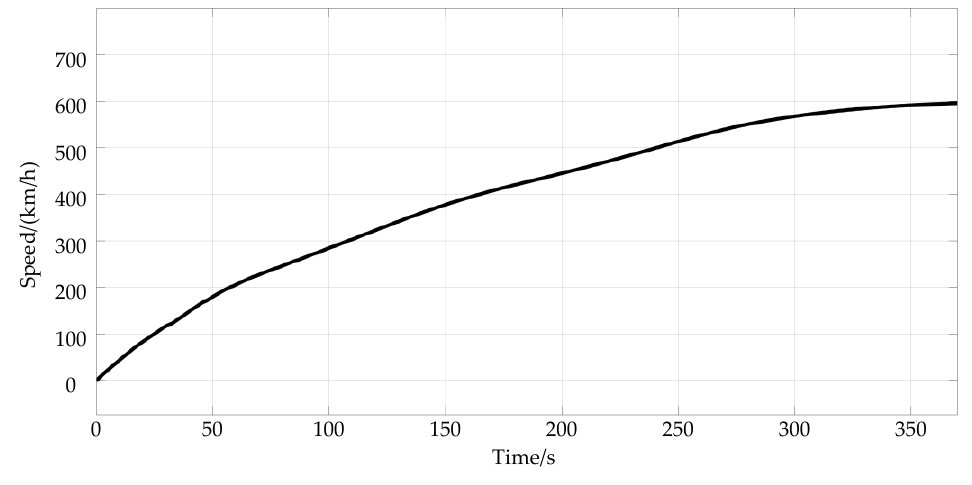
Figure 13. Speed curve of the train.